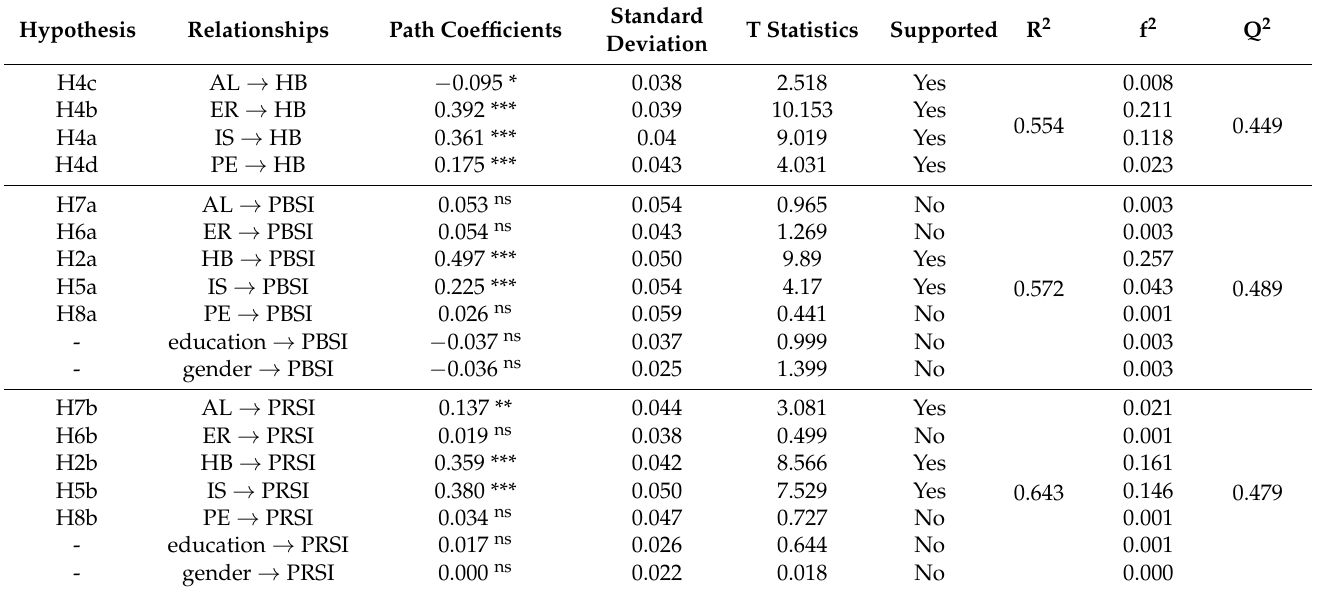
Table 8. Results for structural models.